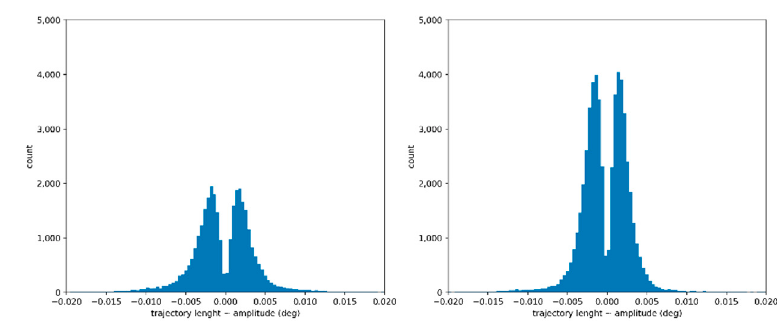
Figure A12. Histogram of the amplitude segments for the painting 1 dataset.